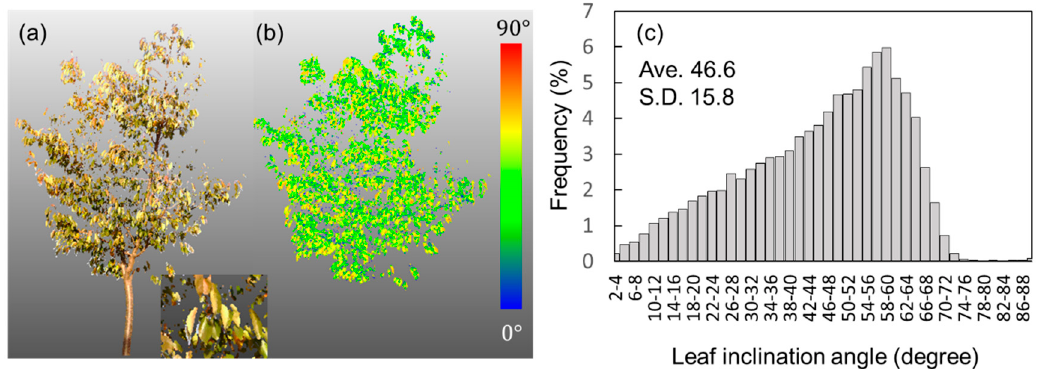
Figure 9. Distribution of leaf inclination angle within a tree (cherry blossom). Panel ( a ) shows reconstructed 3D image obtained from lidar. Panels ( b ) and ( c ) show distribution map of leaf inclination angle and its distribution, respectively.